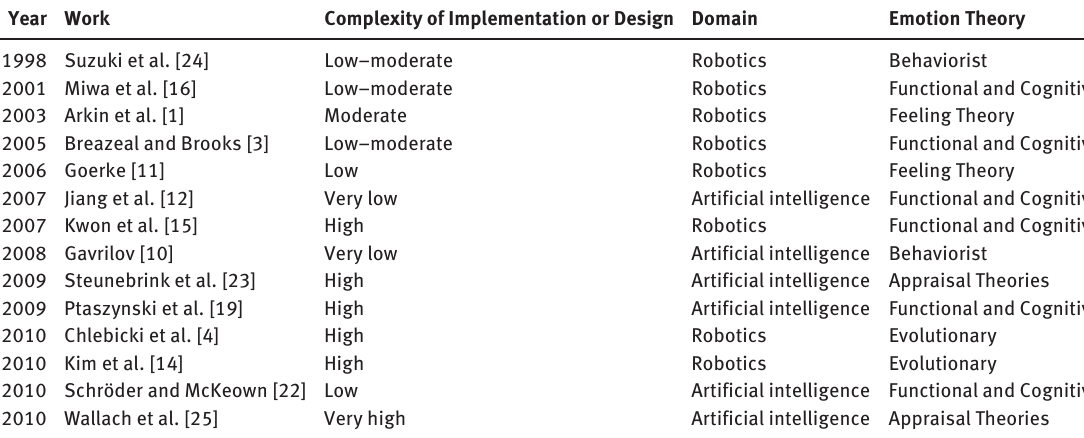
Table 17. Approaches Classified by Complexity, Domain, and Emotion